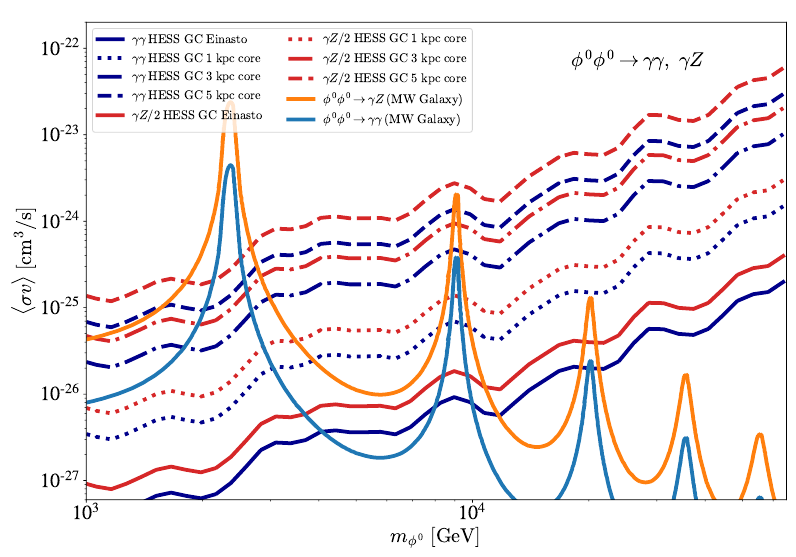
Figure 8: The annihilation cross section for φ 0 φ 0 → γγ (light blue) and φ 0 φ 0 → γ Z (orange) based on the re-summed calculation of Ref. [ 33 ] for comparison with H.E.S.S. bounds from searches for gamma ray lines for different dark matter pro- files (dark blue and red families of curves,